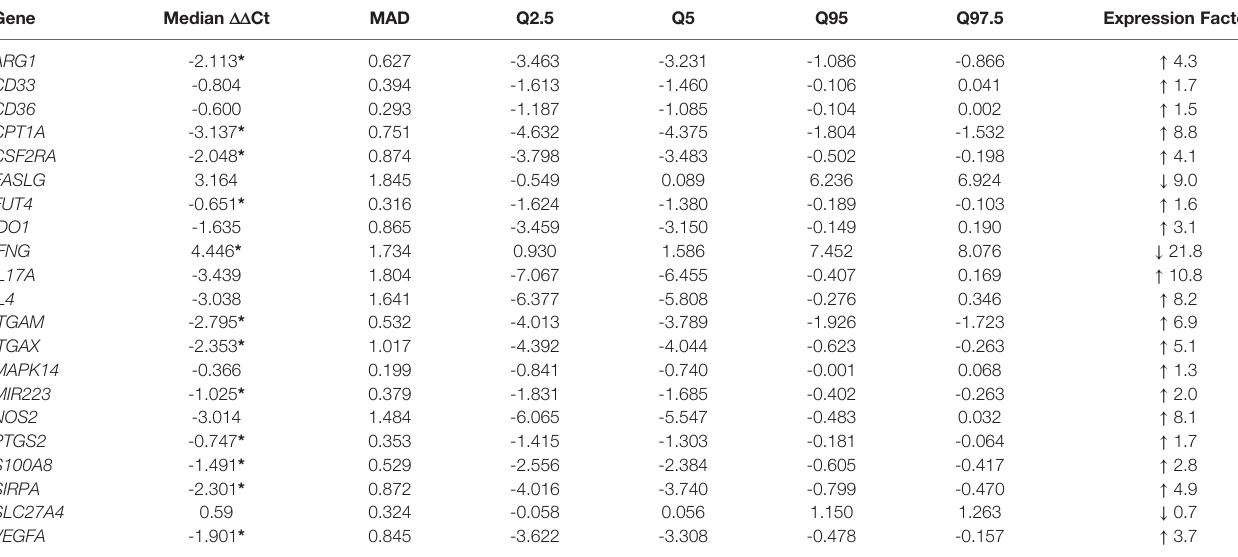
TABLE 3 | Differential gene expression levels between MDSC and Monocytes from PB, with respect to expression levels in Monocytes.